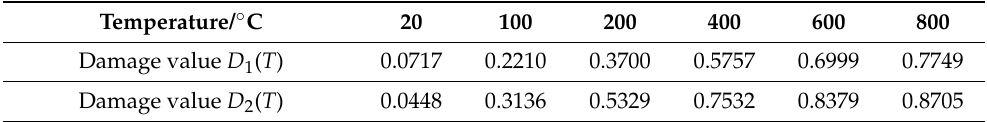
Table 5. Damage values D 1 ( T ) and D 2 ( T ). Temperature/ ◦